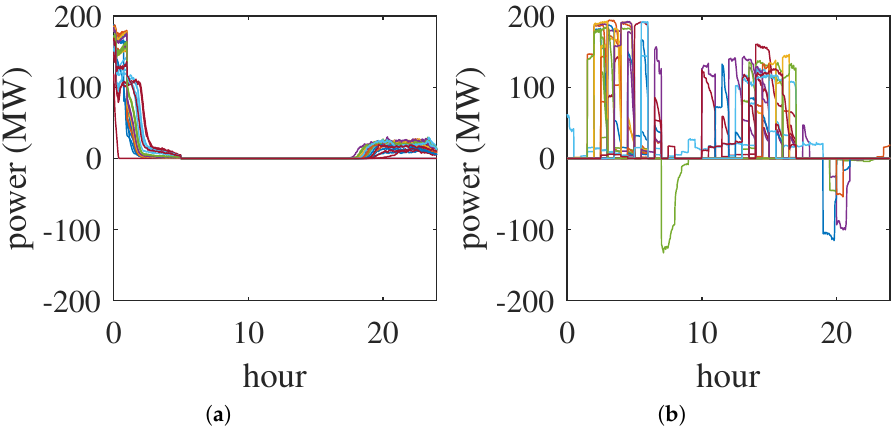
Figure 11. Daily charging profiles for ( a ) night charging and ( b ) scheduled charging in scenario DE-S. Each line represents one day. The influence of solar generation on the scheduling is clearly visible, as is the V2G during morning and evening peak grid